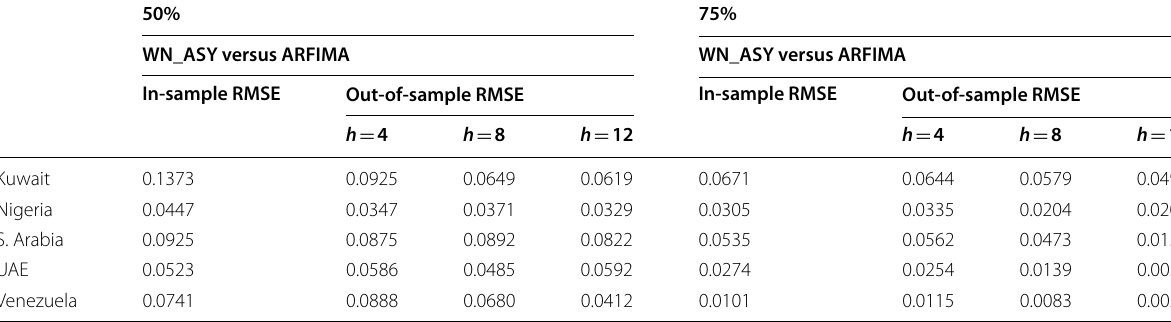
The C–T test results are based on the forecast performance of the proposed asymmetric model (unrestricted model) as against the symmetric model (ARFIMA model). WN_ASY is treated as the unrestricted model and ARFIMA is treated as the restricted model. Intuitively, a positive C–T statistic suggests that the unrestricted model outperforms the restricted model. When there is a negative C–T statistic, it implies that the restricted model surpasses the unrestricted